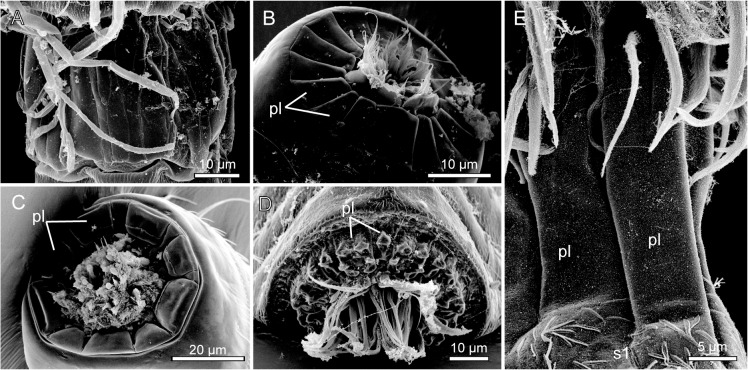
Scanning electron micrographs showing selected morphological character states for characters 7 to 13.A. Segment-like neck region of New Genus (character 7, state 1). B. Meristoderes macracanthus with its head retracted into the trunk, showing the closing mechanism with sixteen placids (character 8, state 1; character 9, state 5) arranged in a radial symmetrical pattern (character 13, state 0). Note also the smooth surface of the placids (character 10, state 0), and the distinct articulations between the placids and segment 1 (character 11, state 1). C. Dracoderes abei with its head retracted into the trunk, showing the closing mechanism with nine placids (character 8, state 1; character 9, state 3). The spacing between the dorsal placids makes the arrangement of the placids bilateral symmetrical (character 13, state 1). D. Condyloderes sp. 1 showing placids with various knobby projections (character 10, state 1). E. Two placids of Triodontoderes anulap. Note the distal tripartition (character 11, state 1) and the absence of distinct articulations between the placids and segment 1 (s1) (character 12, state 0). Abbreviations: pl, placids.